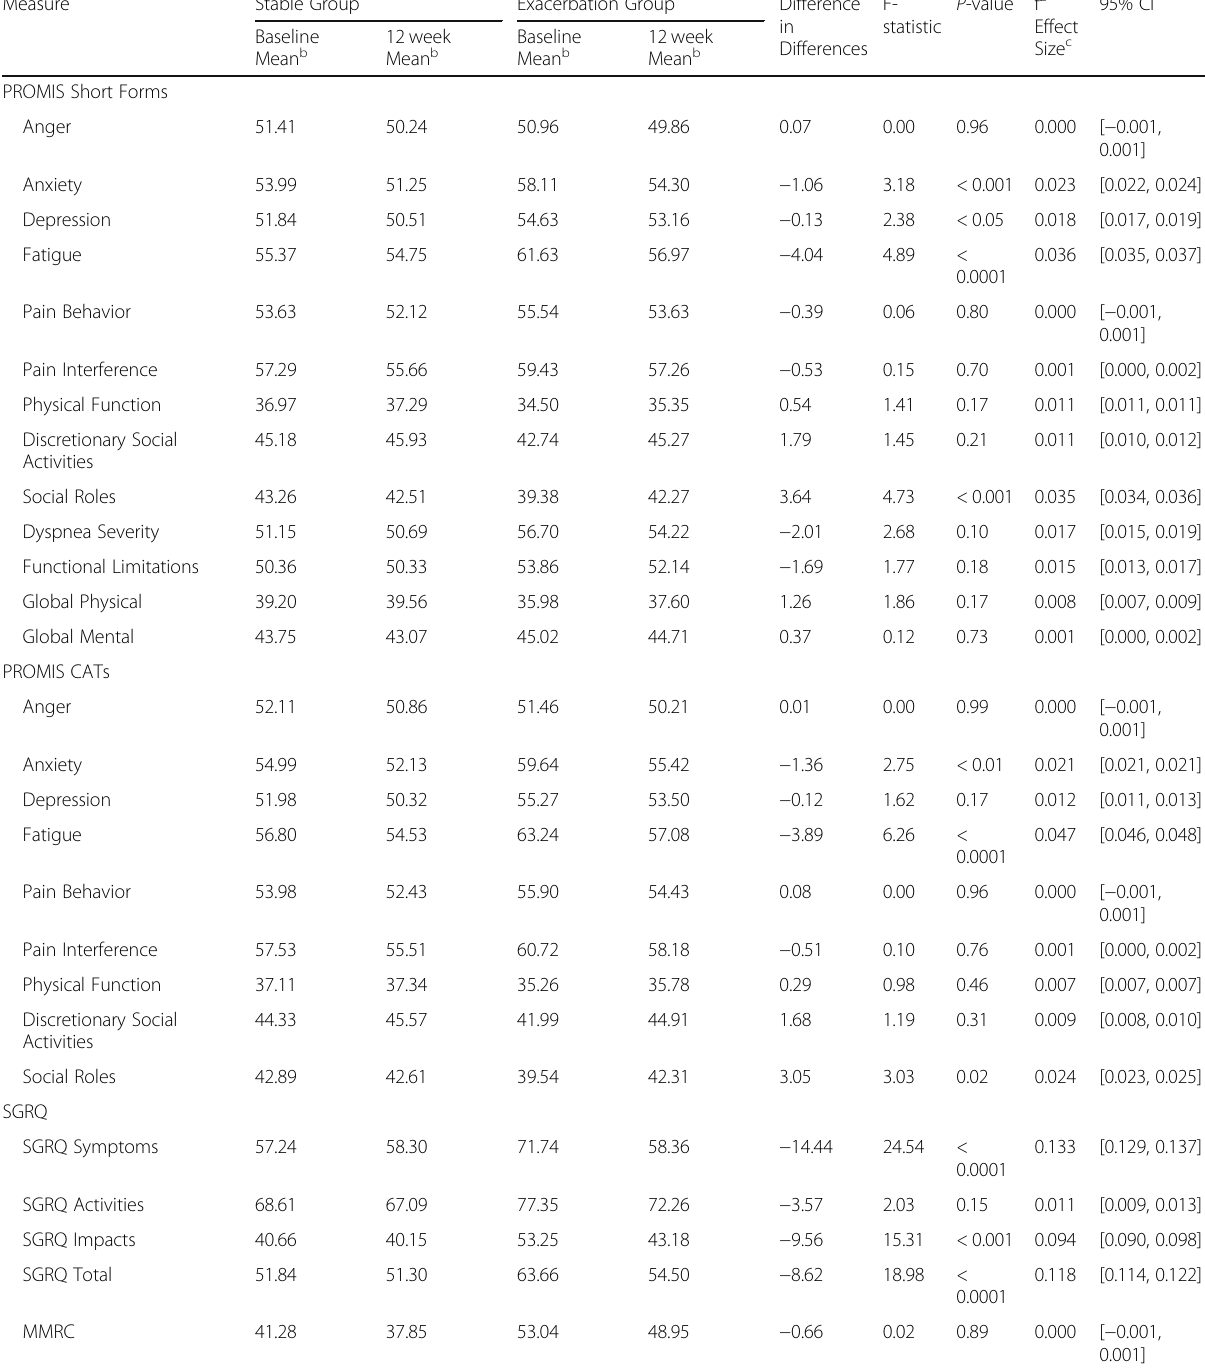
Table 3 Changes in patient-reported outcomes (PRO) scores from mixed model 1 ( N = 185) Measure Stable Group Exacerbation Group Difference